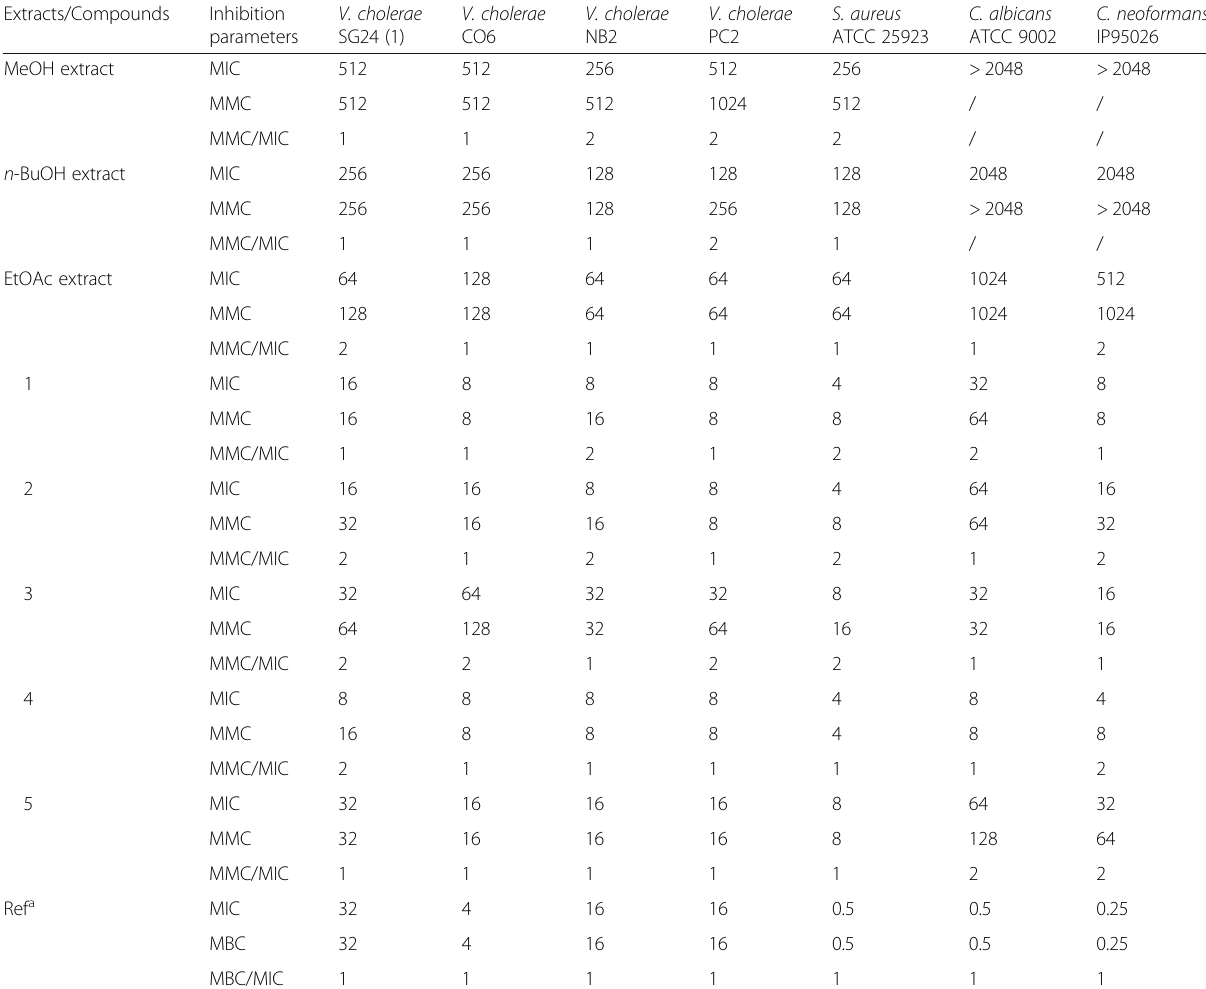
Table 1 Antimicrobial activities of extracts, isolated compounds and reference antimicrobial drugs